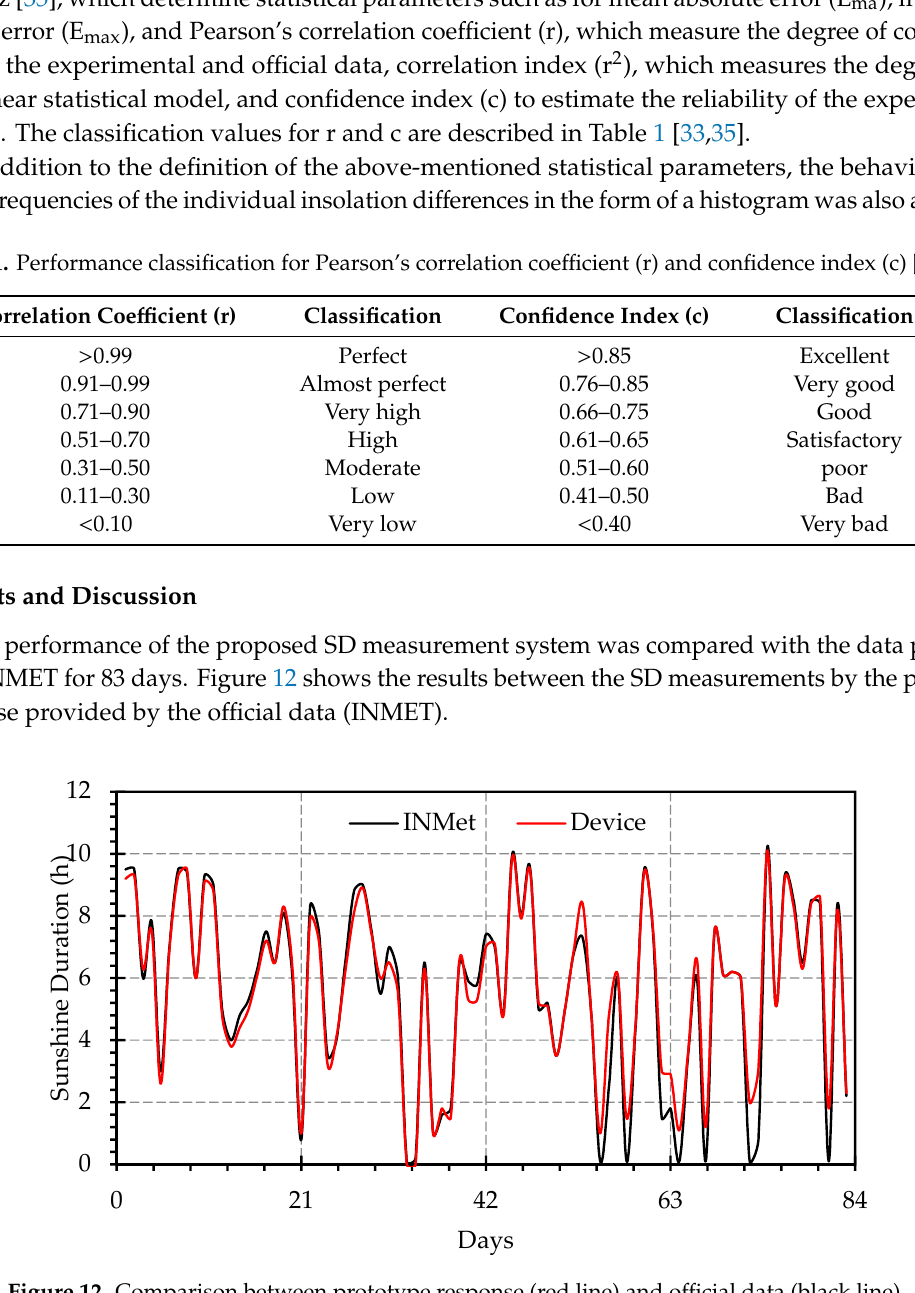
Figure 13. Behavior of daily sunshine readings as a function of the solar hour angle for the device. The analysis of results indicates small divergences between the curves, showing a good tracking response of the system. An analysis of the discrepancies was performed using the histogram in Figure 14 to analyze the characteristics of the distribution of the absolute frequencies of the divergences.